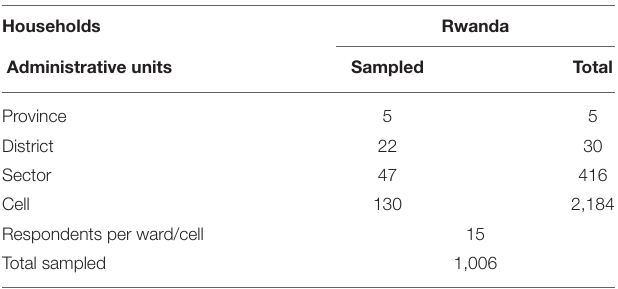
TABLE 3 | Sampling